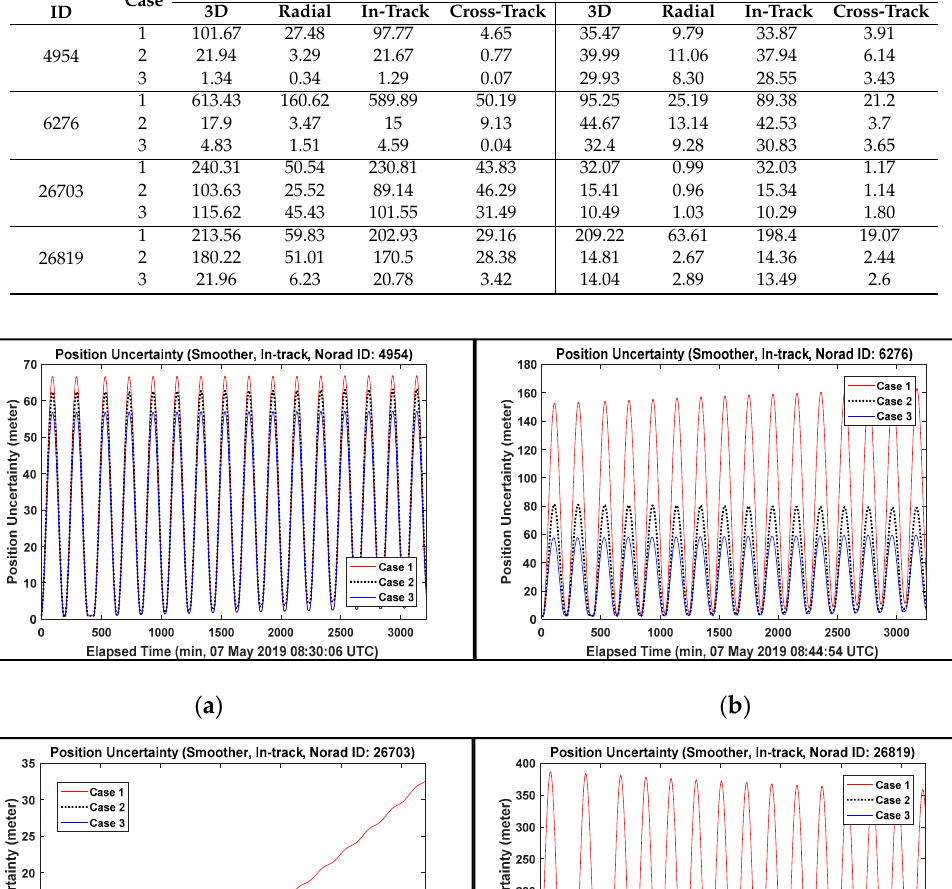
Figure 6. Position di ff erence results of Case 1, 2 and 3. ( a ) ID 4954; ( b ) ID 6276; ( c ) ID 26703; ( d ) ID 26819. Table 9. The 3D position di ff erence RMS and 3D position uncertainty RMS of Case 1, 2 and 3. NORAD ID